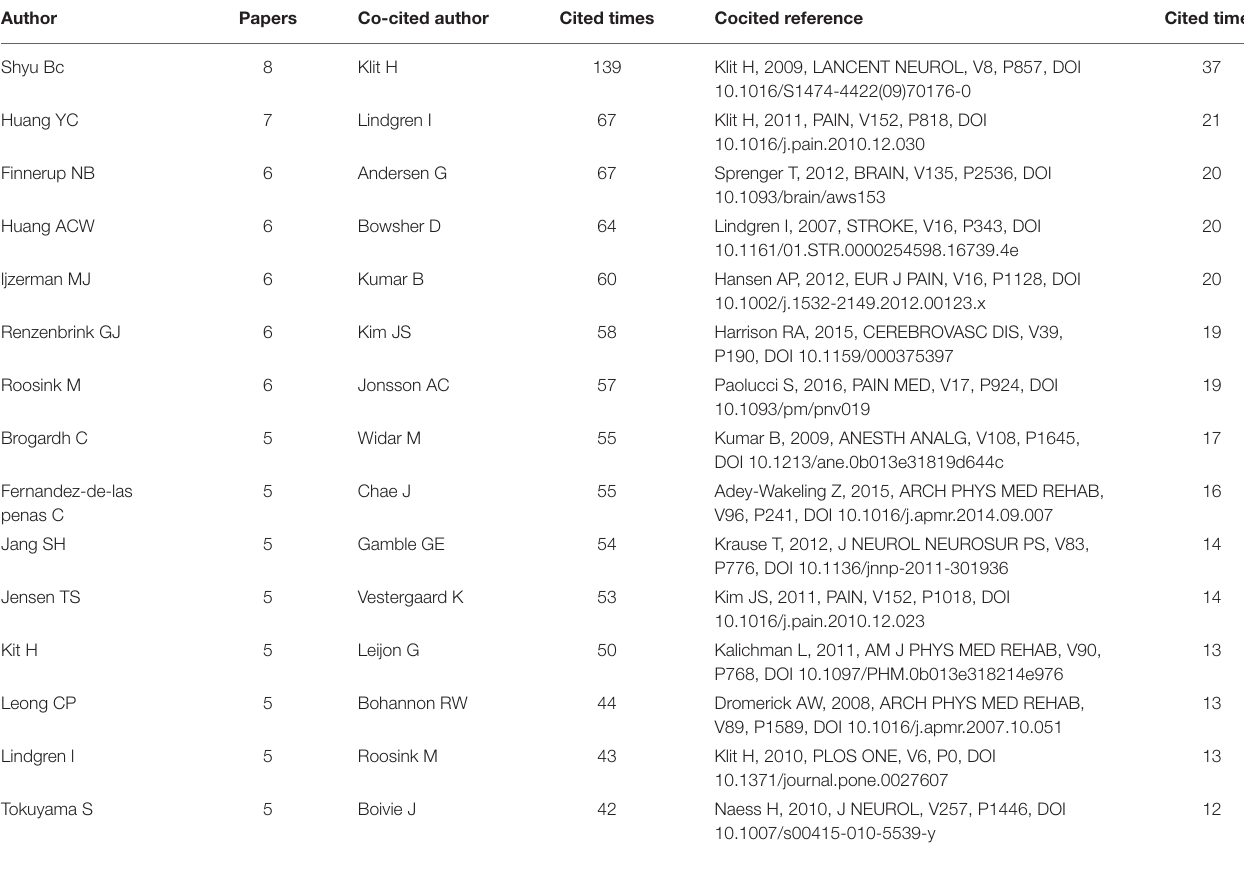
TABLE 3 | The top 15 authors, co-cited authors, and co-cited references in pain after